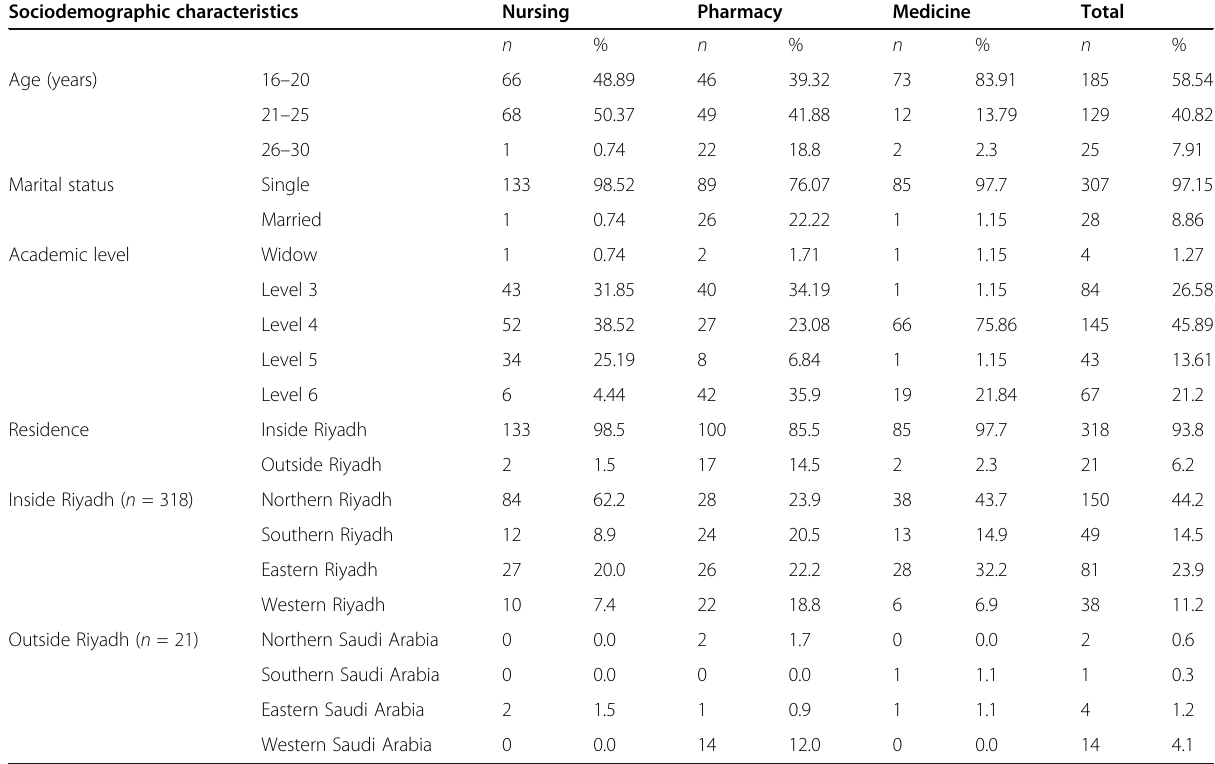
Table 1 Demographic profiles of students from the three colleges at King Saud University ( N = 339) Sociodemographic